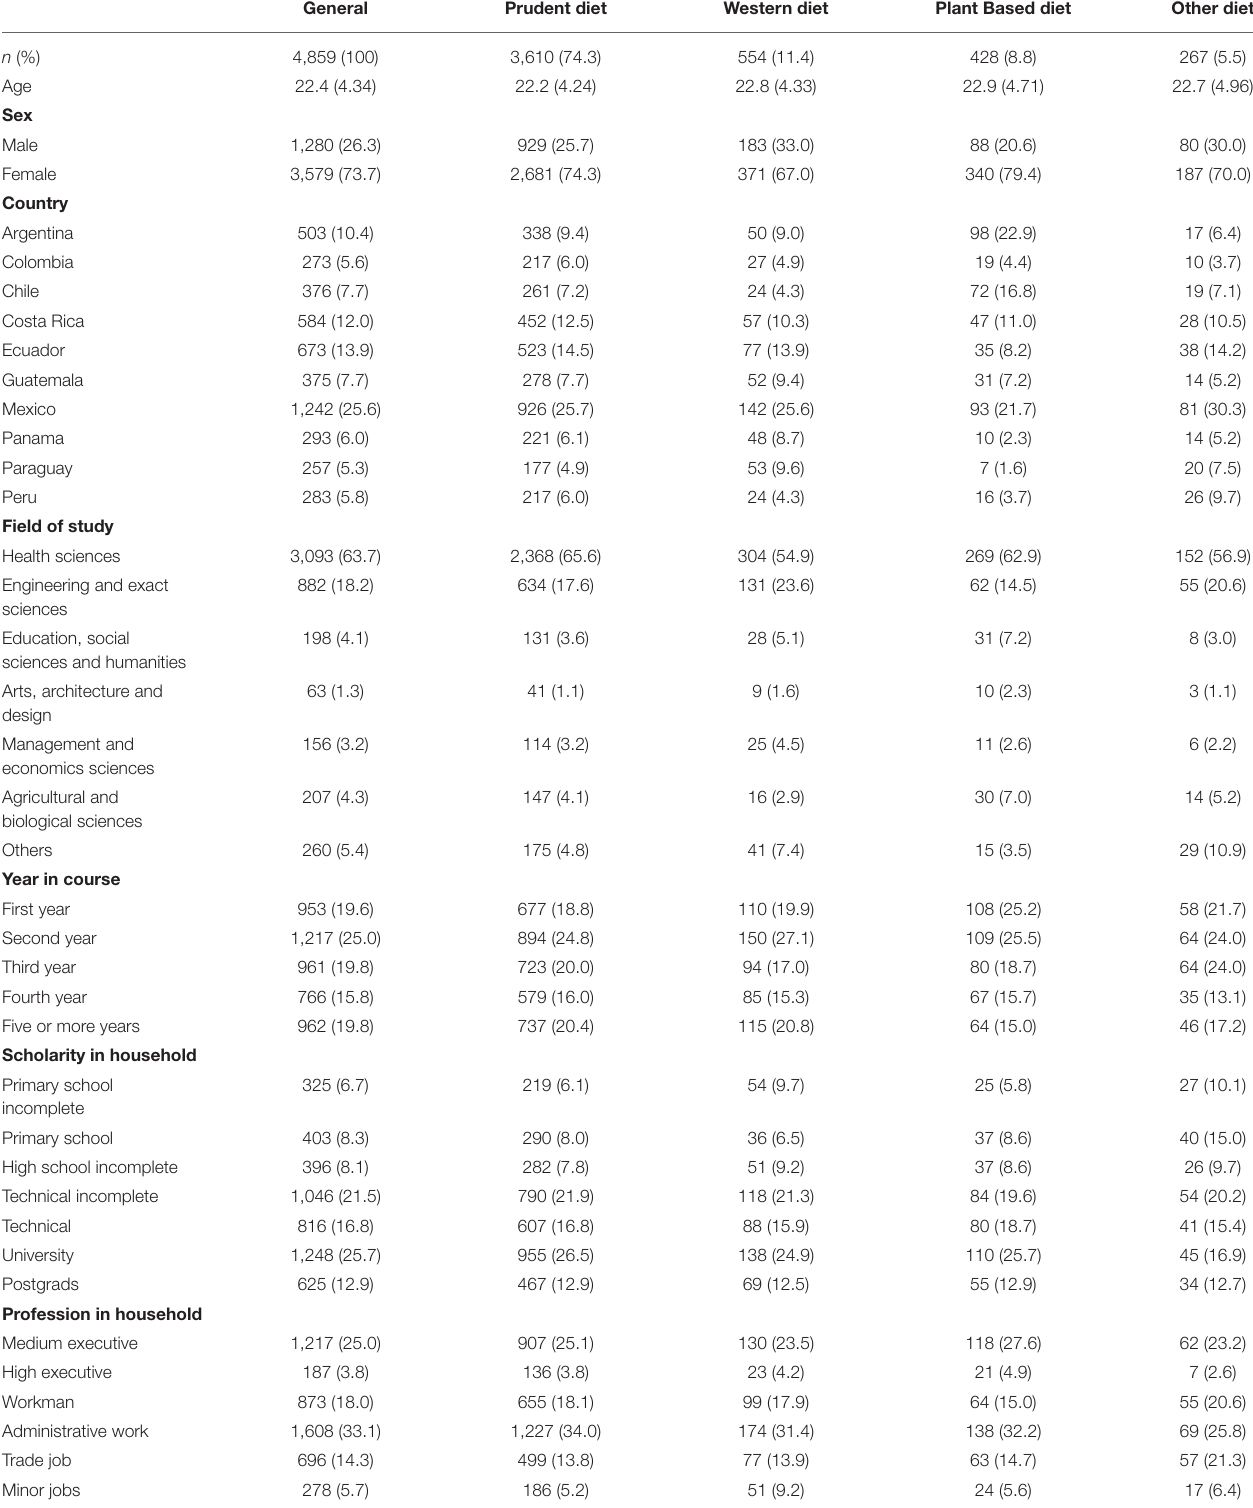
TABLE 1 | Sociodemographic characteristics by dietary pattern. General Prudent diet Western diet Plant Based